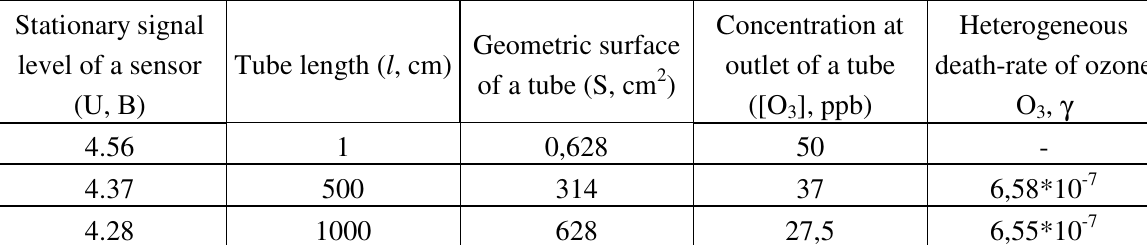
Table 1. Experimental results Stationary